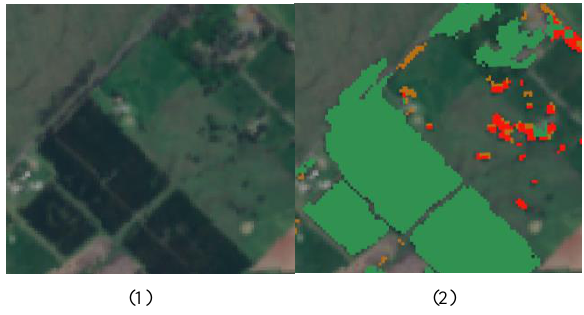
Figure 7: (1) Mosaic image over the city of Ballarat, Australia, and (2) the corresponding confidence map: the green corresponds to code 1, the orange to code 2 and the red to code